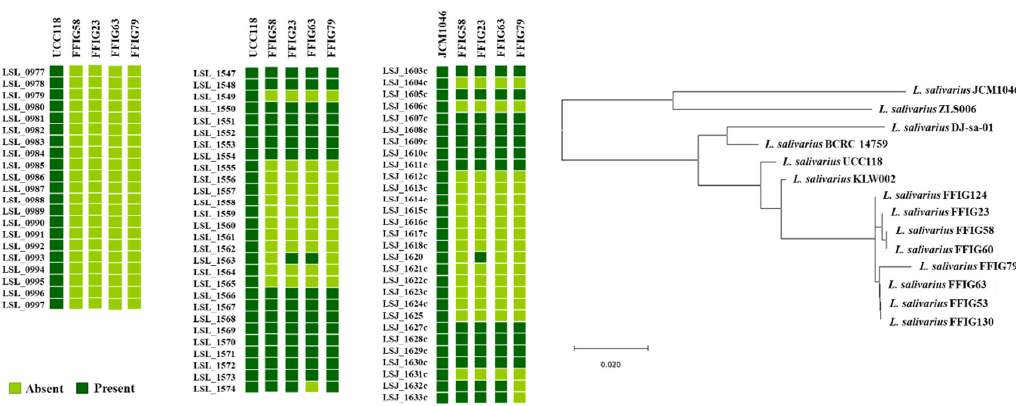
Figure 4. Genomic comparison of the exopolysaccharides (EPS) clusters from Ligilactobacillus salivarius UCC118 and JCM1046 and the L. salivarius strains isolated from the intestinal mucosa of wakame-fed pigs. The phylogenetic tree was constructed by using the sequences of the twelve genes sheared by the strains that are conserved and were considered as EPS core genes.